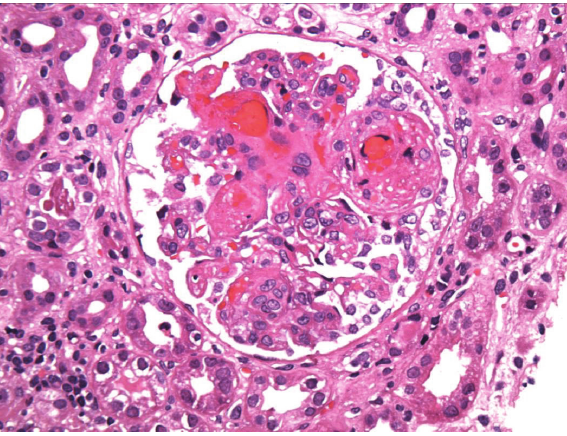
Figure 2: Kidney biopsy showing thrombotic